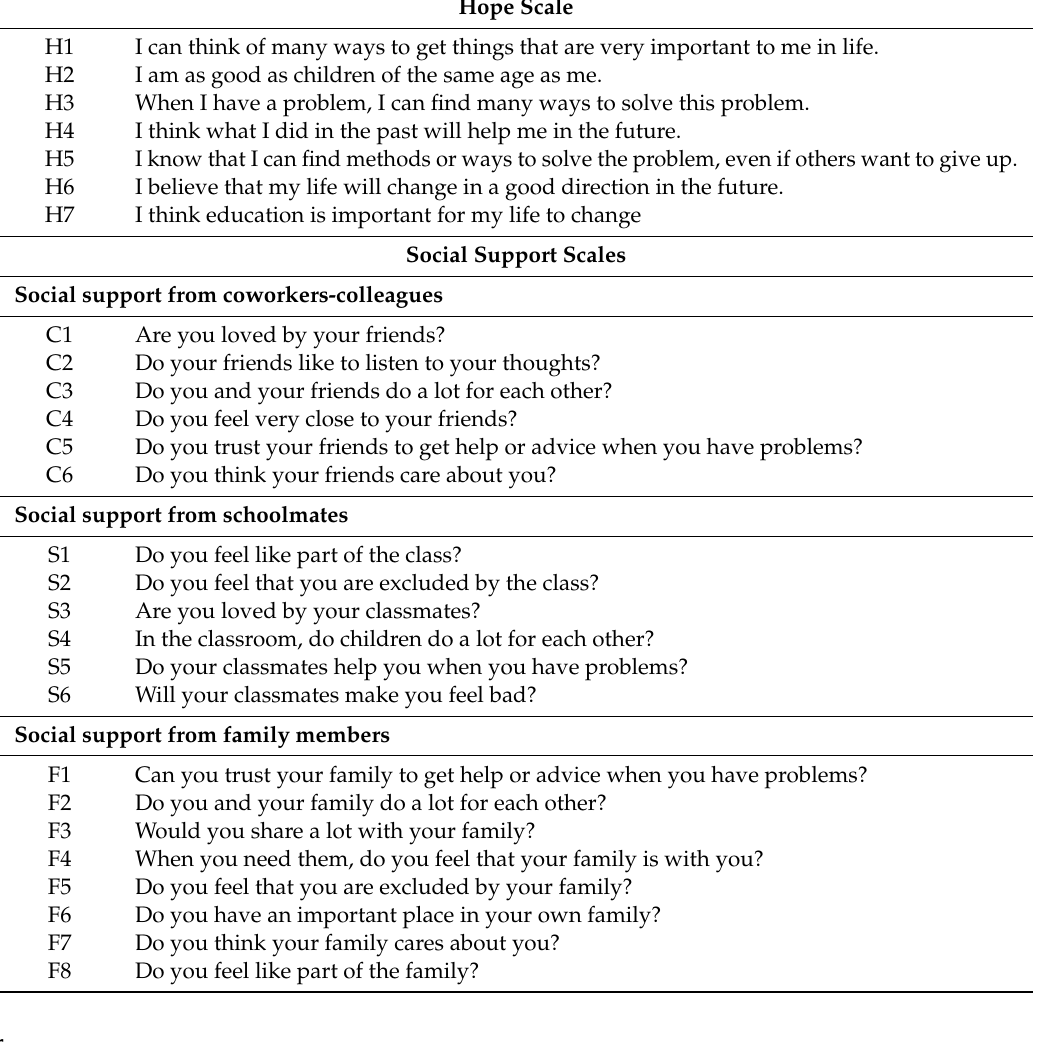
Table A1. The hope and social support scale questions used in the survey Hope